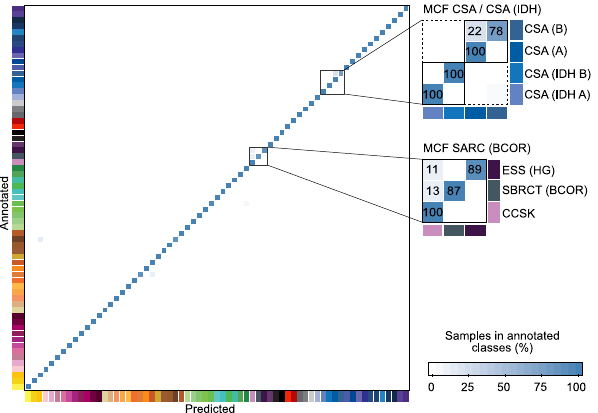
Fig. 2 Cross-validation of the DNA methylation-based sarcoma classi fi er. Heat map showing results of a threefold cross-validation of the Random Forest classi fi er incorporating information of n = 1077 biologically independent samples allocated to 65 methylation classes. Deviations from the bisecting line represent misclassi fi cation errors (using the maximum calibrated score for class prediction). Methylation class families (MCF) are indicated by black squares. The colour code and abbreviations are identical to Fig. 1a. Numbers of this fi gure are summarized in Supplementary Data 4.